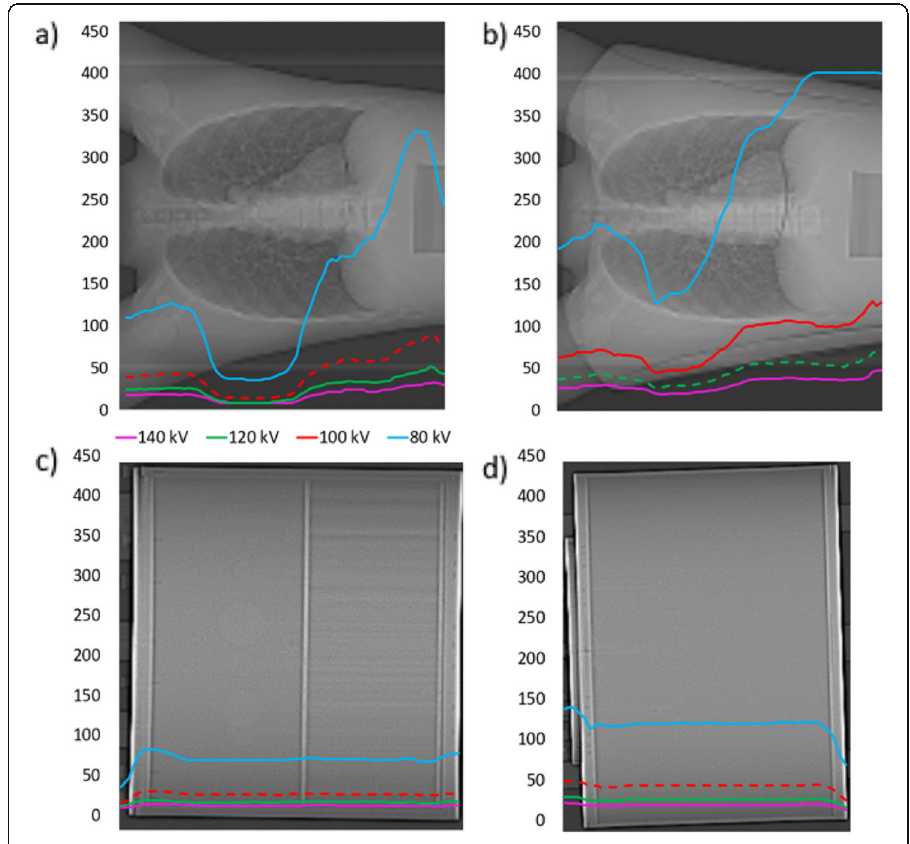
Fig. 2 Axial mAs profiles for scans at each kV for a Lungman, b Lungman plus fat, c Esser and d NEMA IQ phantoms. Optimal kV determined by ‘ CARE kV on ’ mode shown with dashed profile. Minimum deliverable 13 mAs effective using selected